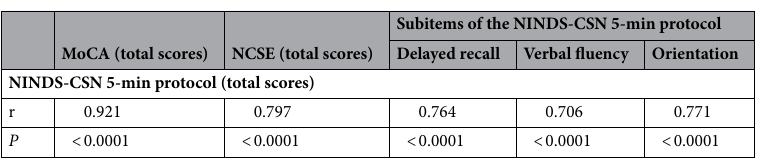
Table 2. Summary of correlation analyses (NINDS-CSN 5-min protocol). MoCA, Montreal Cognitive Assessment.; NINDS-CSN 5-min Protocol, National Institute for Neurological Disorders and Stroke-Canadian Stroke Network 5-minute Protocol; MoCA, Montreal Cognitive